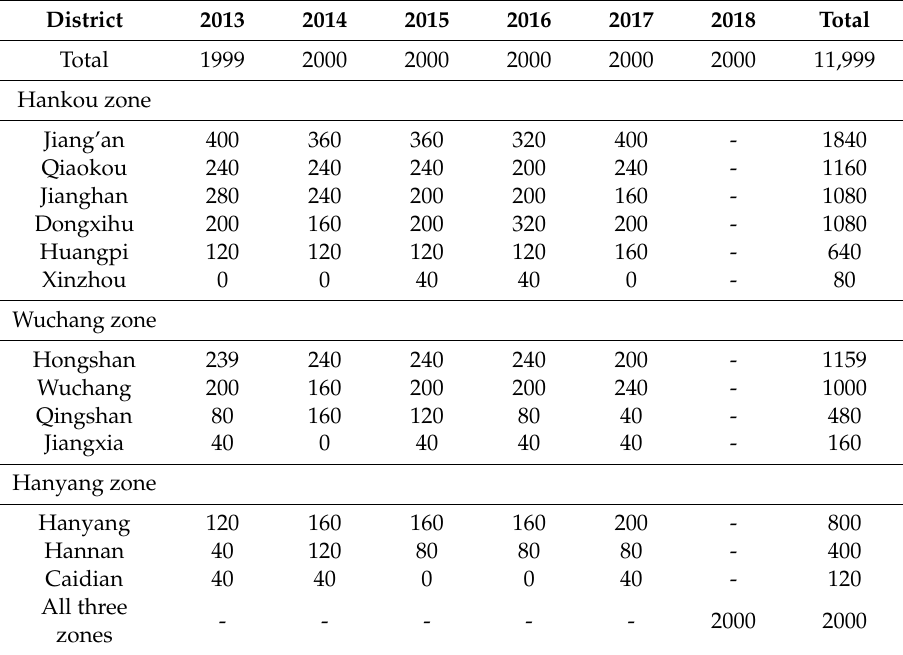
Table 1. Sample distribution of floating population living in Wuhan,